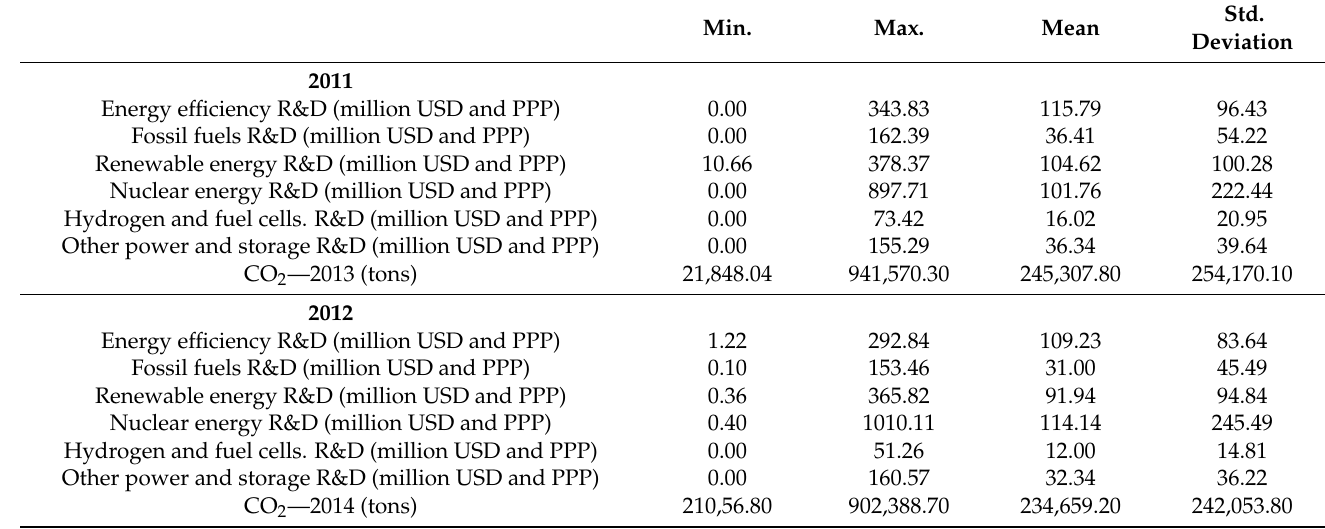
Table 1. Descriptive statistics of